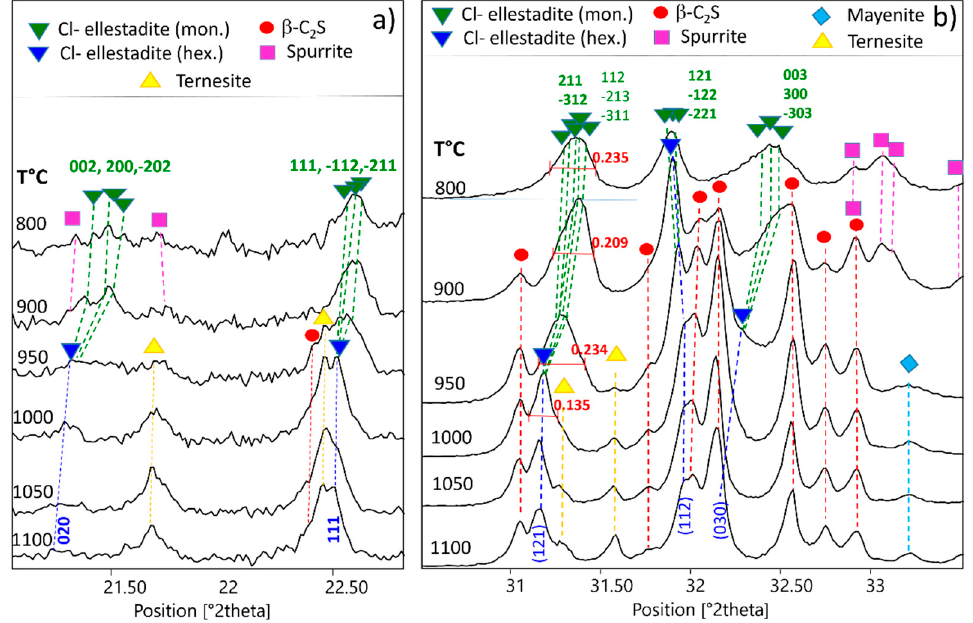
Figure 3. XRD patterns of sample D2 calcined at different temperatures. ( a ) 21–23 ◦ 2 theta range, splitting of the hexagonal 020 reflection (1000 ◦ C) to 002, 200, − 202 monoclinic reflections (sample 800 ◦ C). The decreasing intensity ratio of the 111/020 reflections in the samples from 1000 to 800 ◦ C corresponds to incorporation of CO 3 instead of SO 4 groups; ( b ) 30.5–33.5 ◦ 2 theta range. Samples treated at 800, 900, and 950 ◦ C, show very broad peaks pointing to lower symmetry and/or very small size of coherent scattering domains. The integral breadth of the doublet 211 and − 312 with three additional reflections with low intensity (monoclinic) is 0.235 ◦ 2 theta in the 800 ◦ C sample, whereas the corresponding hexagonal reflection 121 shows 0.135 ◦ 2 theta in the 1000 ◦ C